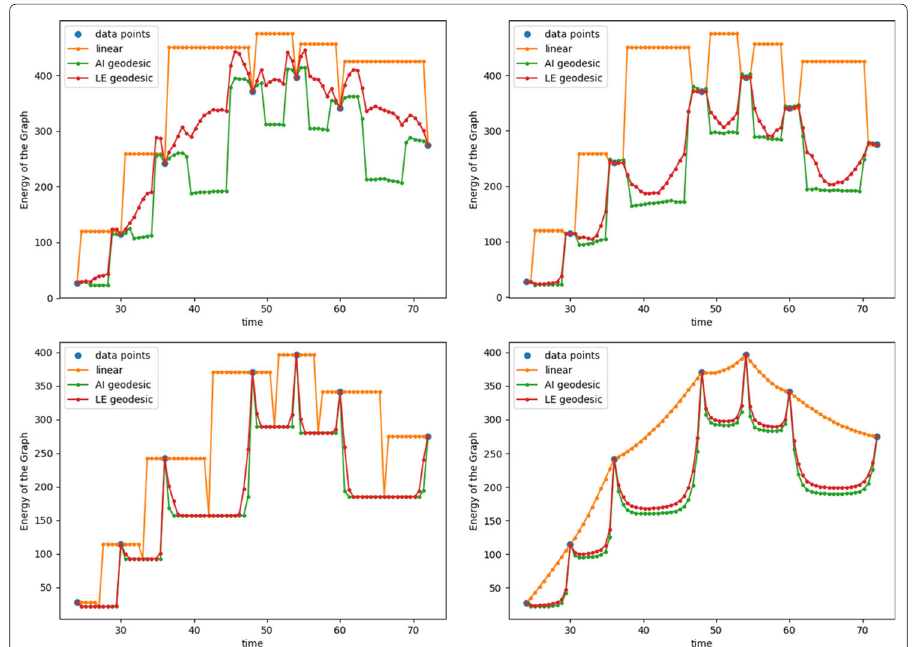
Fig. 11 Graph energy in interpolated proteomics network. Applying thresholds of 0.5 ( bottomleft ), 0.1 ( top right ), and 0.02 ( topleft ) produced the same kind of trends in the interpolations’ graph energy as was the